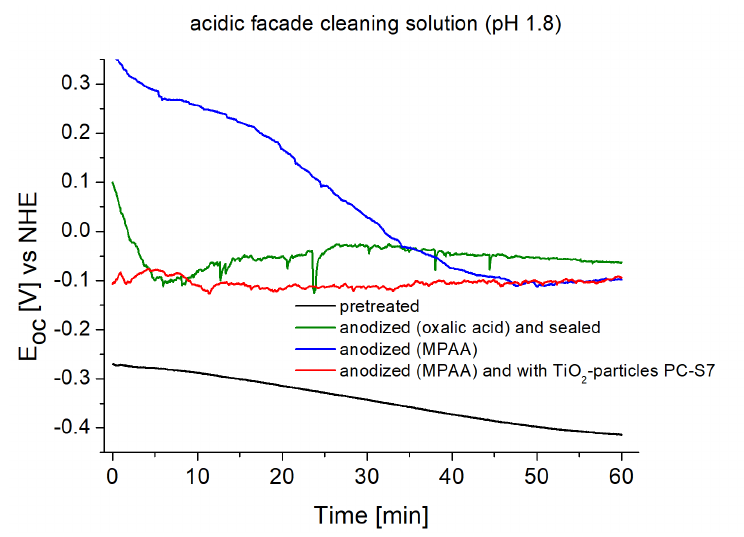
Figure 9. Development of open-circuit potential for different AlMg1 samples.